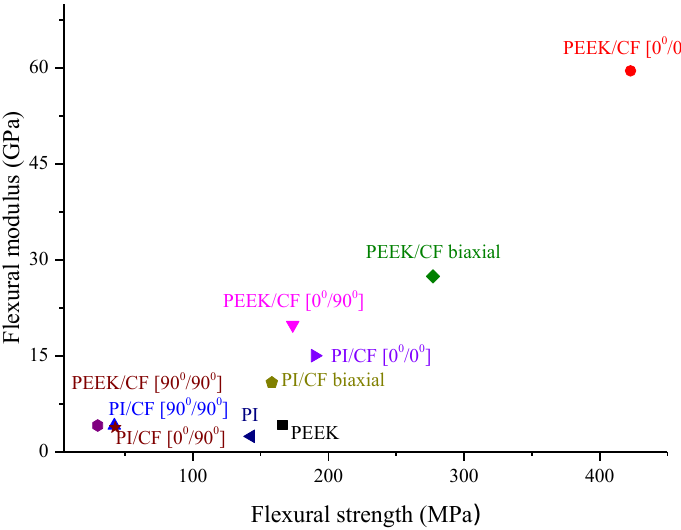
Figure 7. The summarized mechanical test results for both PEEK- and PI-based composites in the flexural ‘strength–modulus’ coordinates.